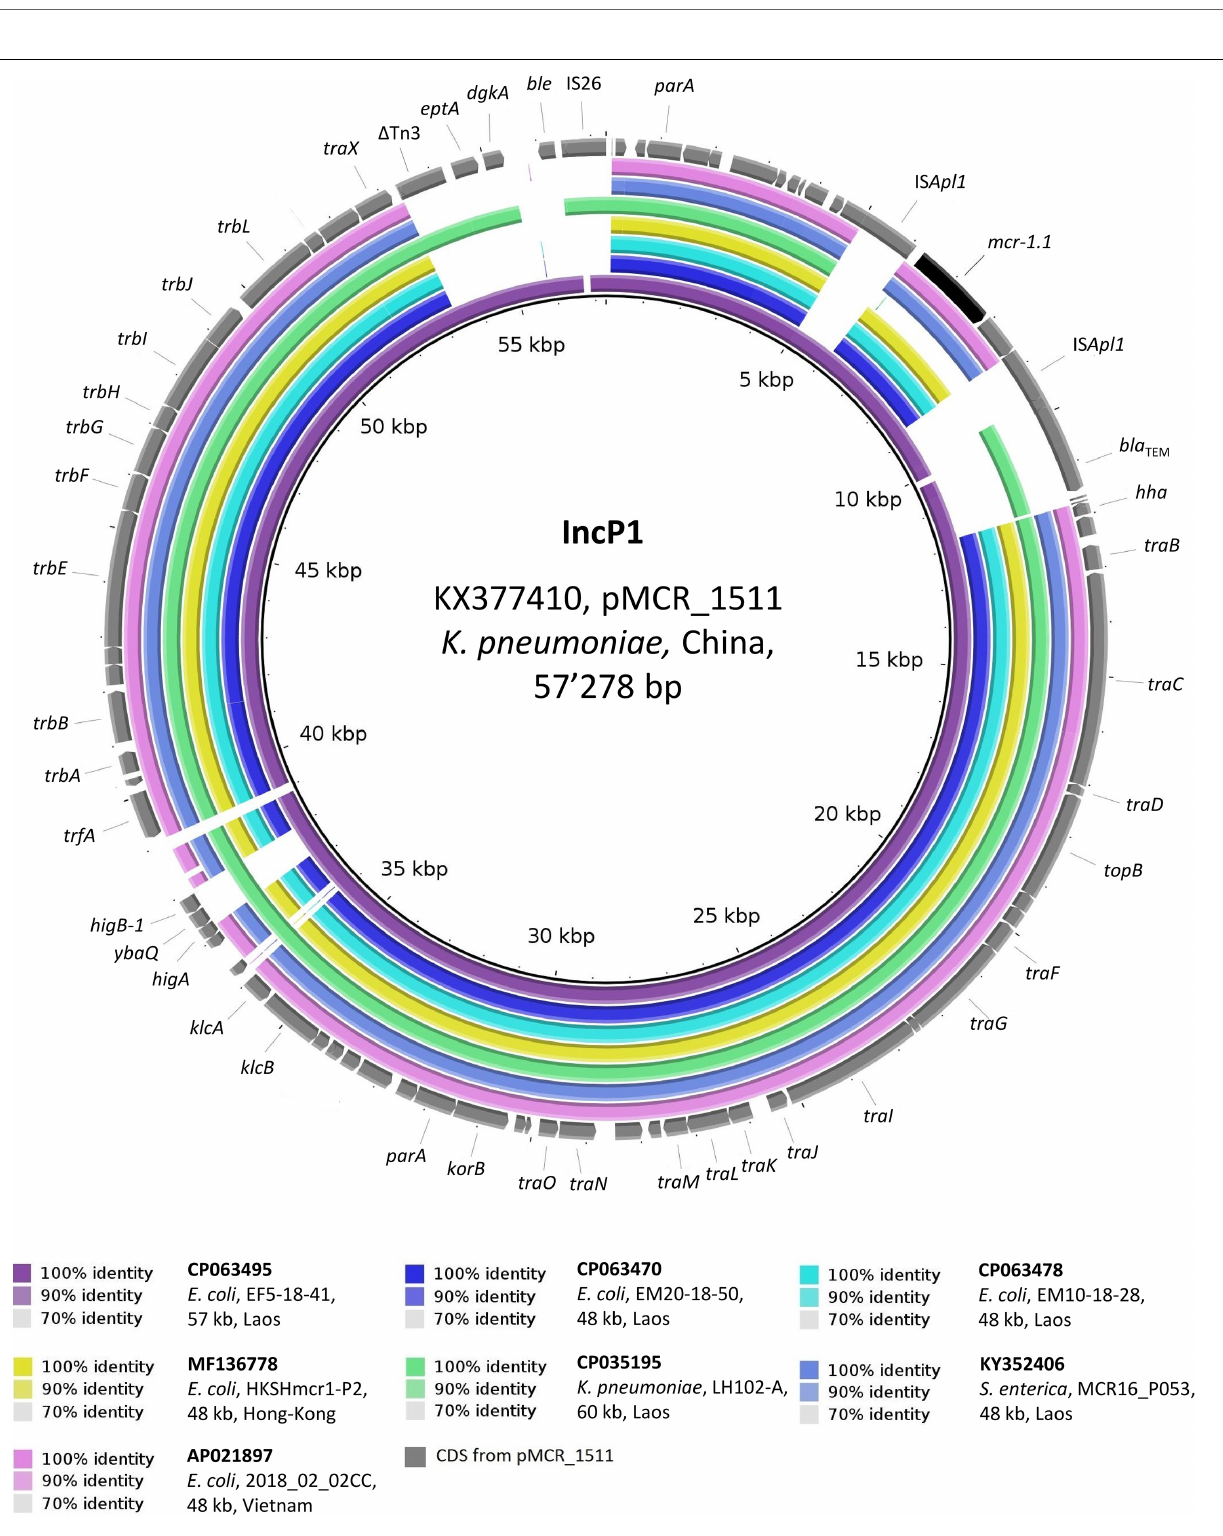
Frontiers in Microbiology |